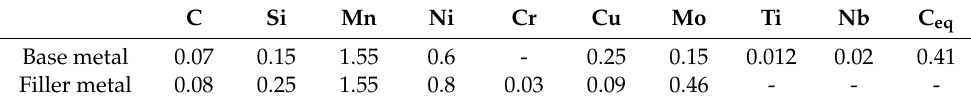
Table 1. Chemical composition of the base metal and filler metal.